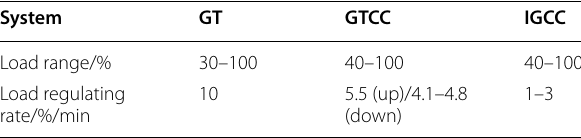
Table 1 Variable load characteristics of the different